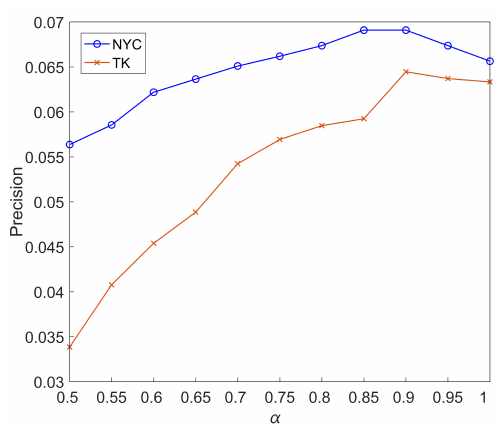
Figure 3. Parameter α for two-person group.